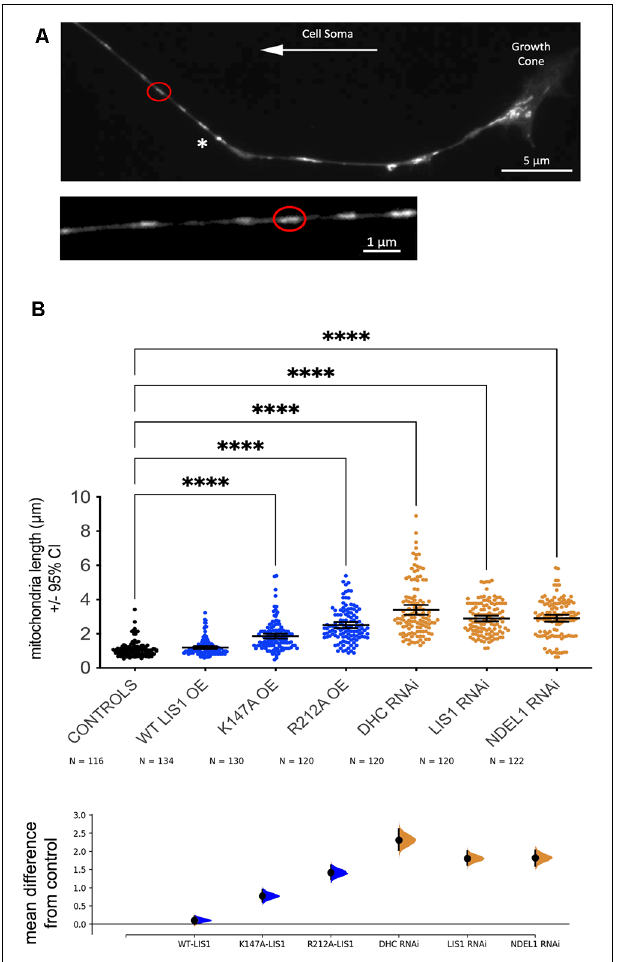
FIGURE 4 | Manipulations that reduce retrograde transport of mitochondria also cause an increase in the length of axonal mitochondria. (A) Axonal mitochondria were visualized using mitotracker red in fixed cultures of adult rat DRG neurons. The lengths of individual mitochondria were measured in axon shafts at least 30 µ m from cell bodies, branch points or growth cones. The lower panel shows a digital enlargement of the axon region the top panel that contains the circled mitochondrion. (B) Size measurements are shown for the indicated groups. Total numbers of mitochondria measured are shown below the X-axis labels. The raw data is plotted on the upper axes. Each point corresponds to a single axon (of 15 total from three independent cultures from three different rats). Error bars show ± 95% confidence interval. The effect size is visualized on the lower axes, in which mean differences from a shared control are plotted as bootstrap sampling distributions. Mean difference is depicted as a dot and a 95% confidence interval is indicated by the ends of the vertical error bars. ScrRNA and EGFP controls were combined because they were similar. Expression of LIS1-K147A or LIS1-R212A significantly increased mitochondrial lengths, as did RNAi targeting DHC, LIS1, or NDEL1. WT LIS1 OE did not significantly impact lengths. Significance was determined by Kruskal Wallis nonparametric ANOVA with multiple comparisons using the two-stage linear step-up procedure of Benjamini, Kreiger and Yekutieli to control for false discovery rate. ∗∗∗∗ p <